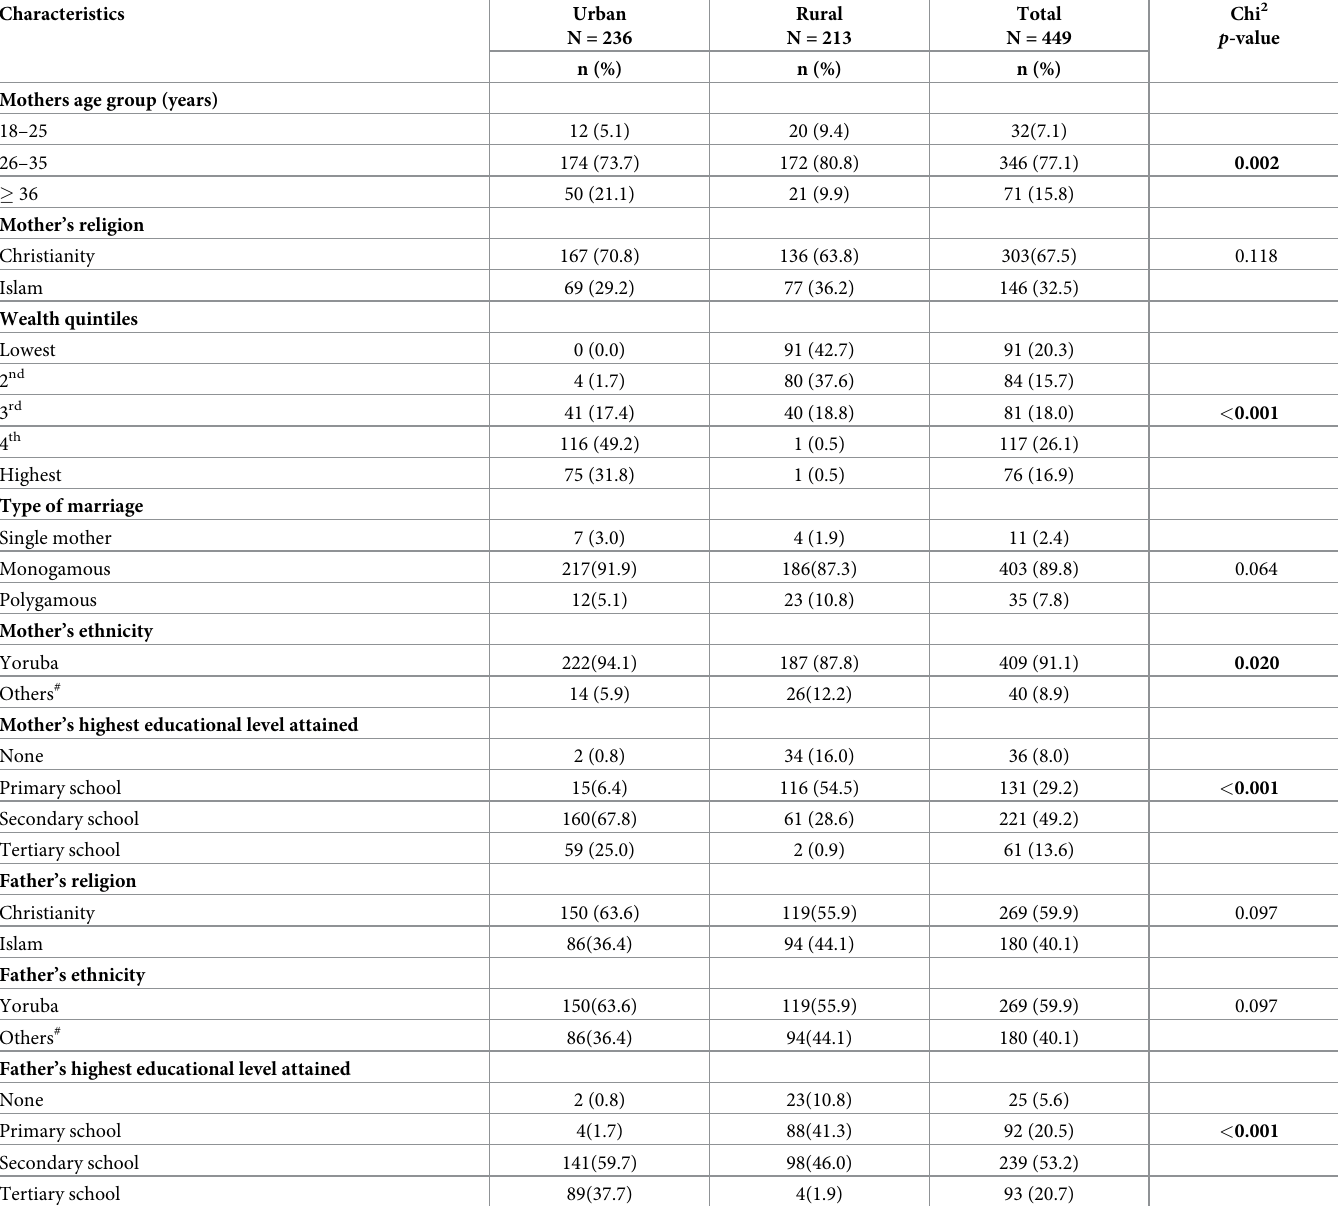
Table 1. Socio-demographic characteristics of parents by location, Akinyele LGA, Oyo State, Nigeria—2013.